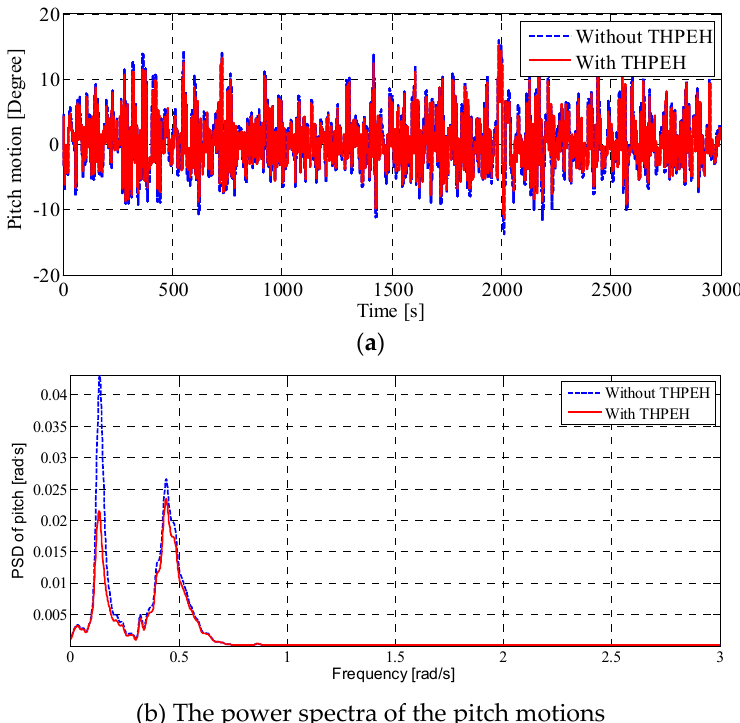
Figure 17. ( a ) The time histories of the pitch motion with and without the THPEH system under IRW ‐ 1;